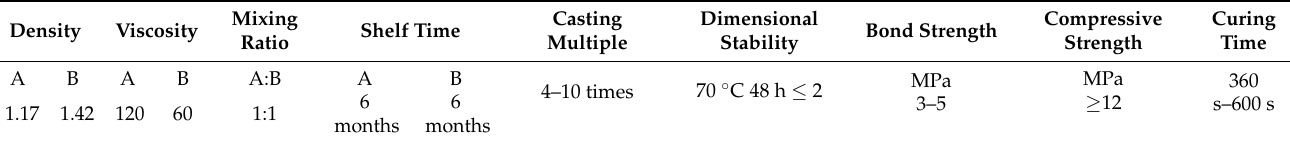
Table 1. Basic parameters of time-delay foamed polyurethane.